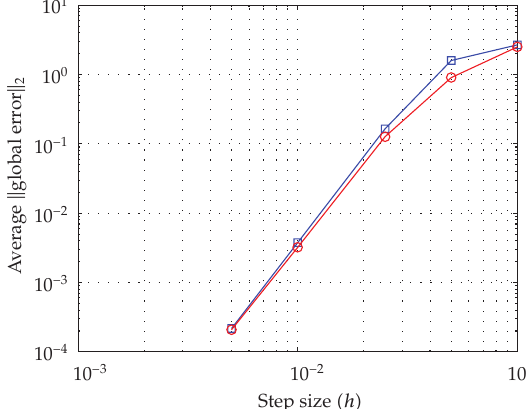
Figure 13: Comparison of the accuracy of the ARK4 (cid:4) blue (cid:5) and TSRK4 (cid:4) red (cid:5) methods in solving